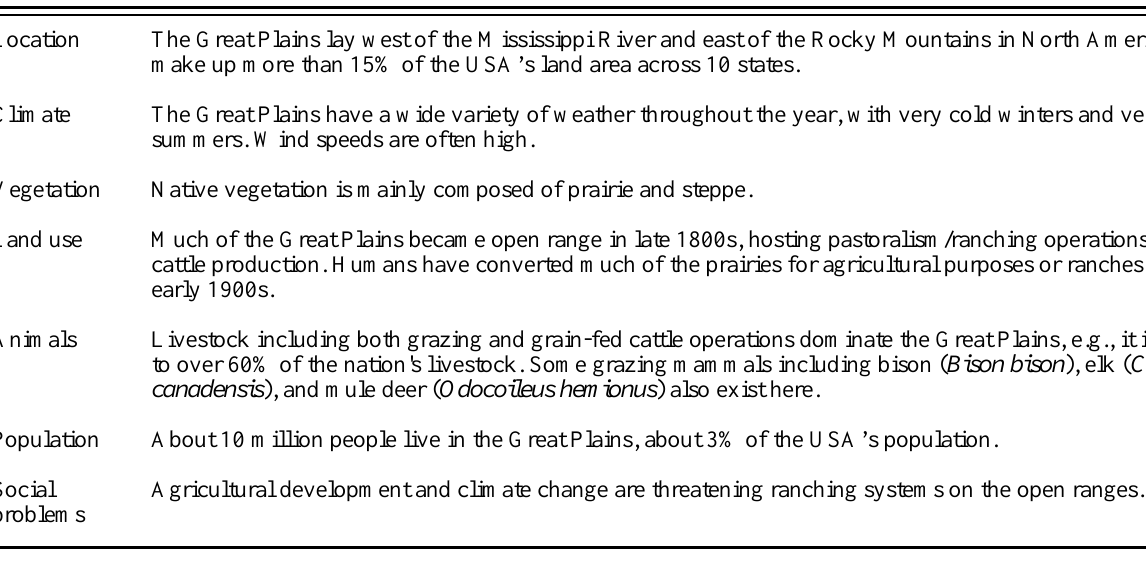
Table 5. General information on the Great Plains of North America (Wood 1998).